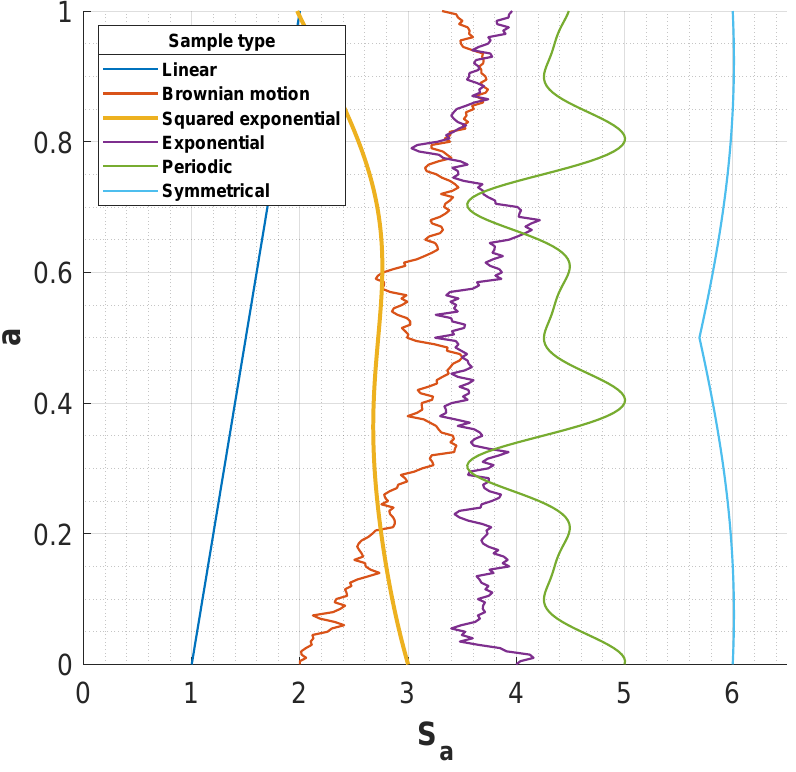
Figure 3. Realisations of different 1 D Gaussian processes generated by diverse covariance functions or kernel and represented as wind